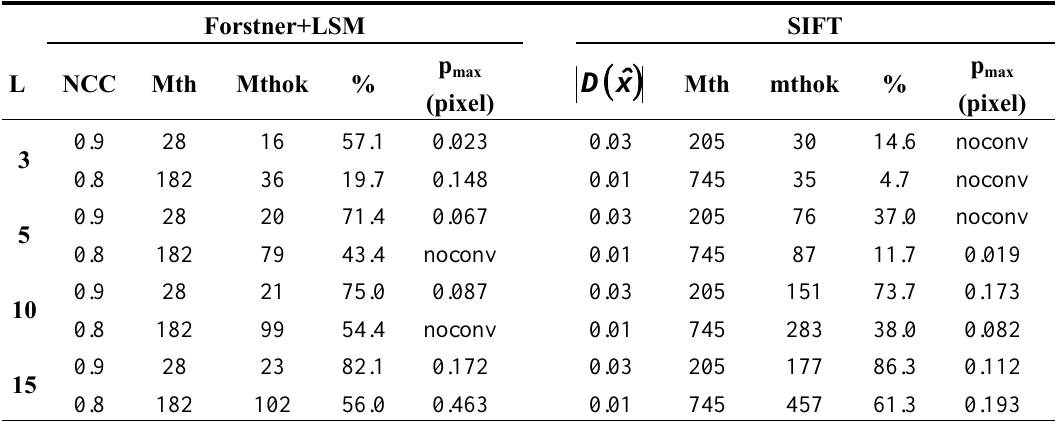
Table 6. The Villareggia test 2. The experimental results of the examined operators, in relation to the NCC ,   x ˆ D and L